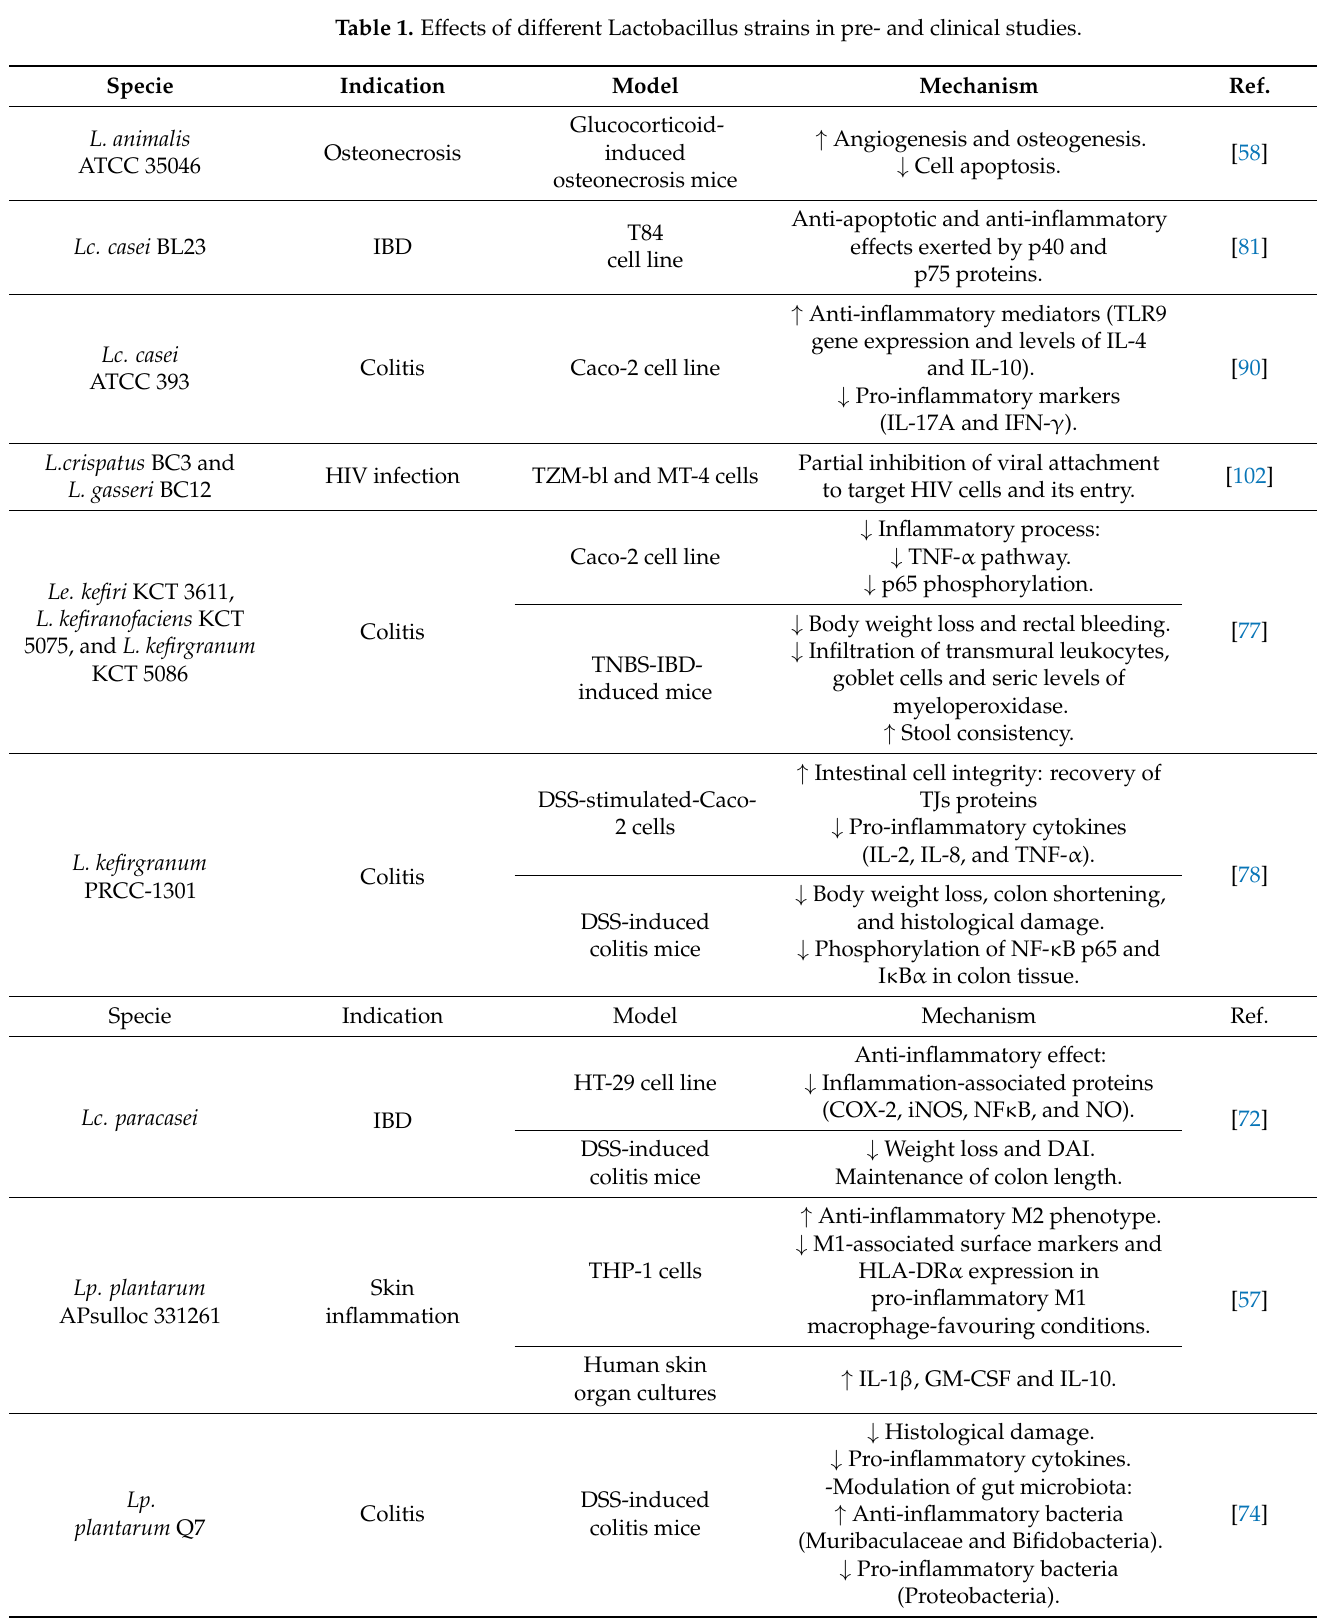
Table 1. Effects of different Lactobacillus strains in pre- and clinical